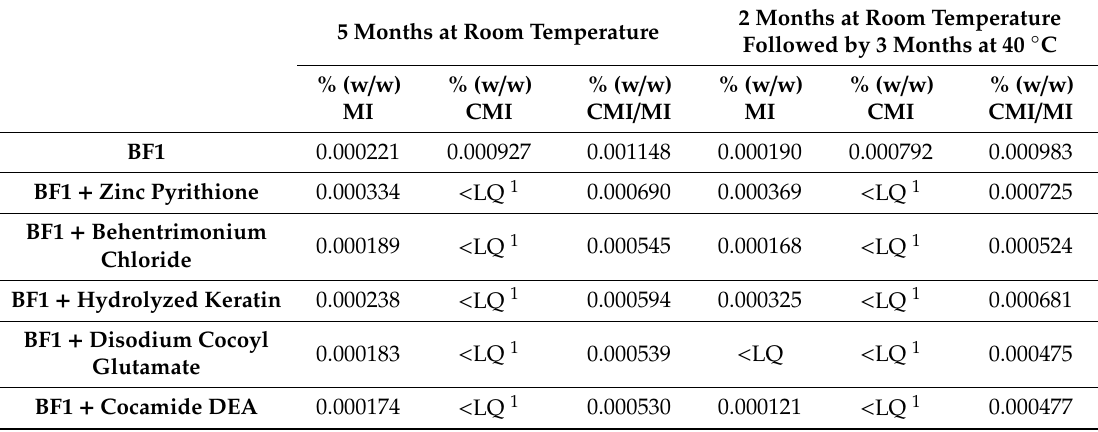
Table 7. Preservative quantification after storage at room temperature and 40 ◦